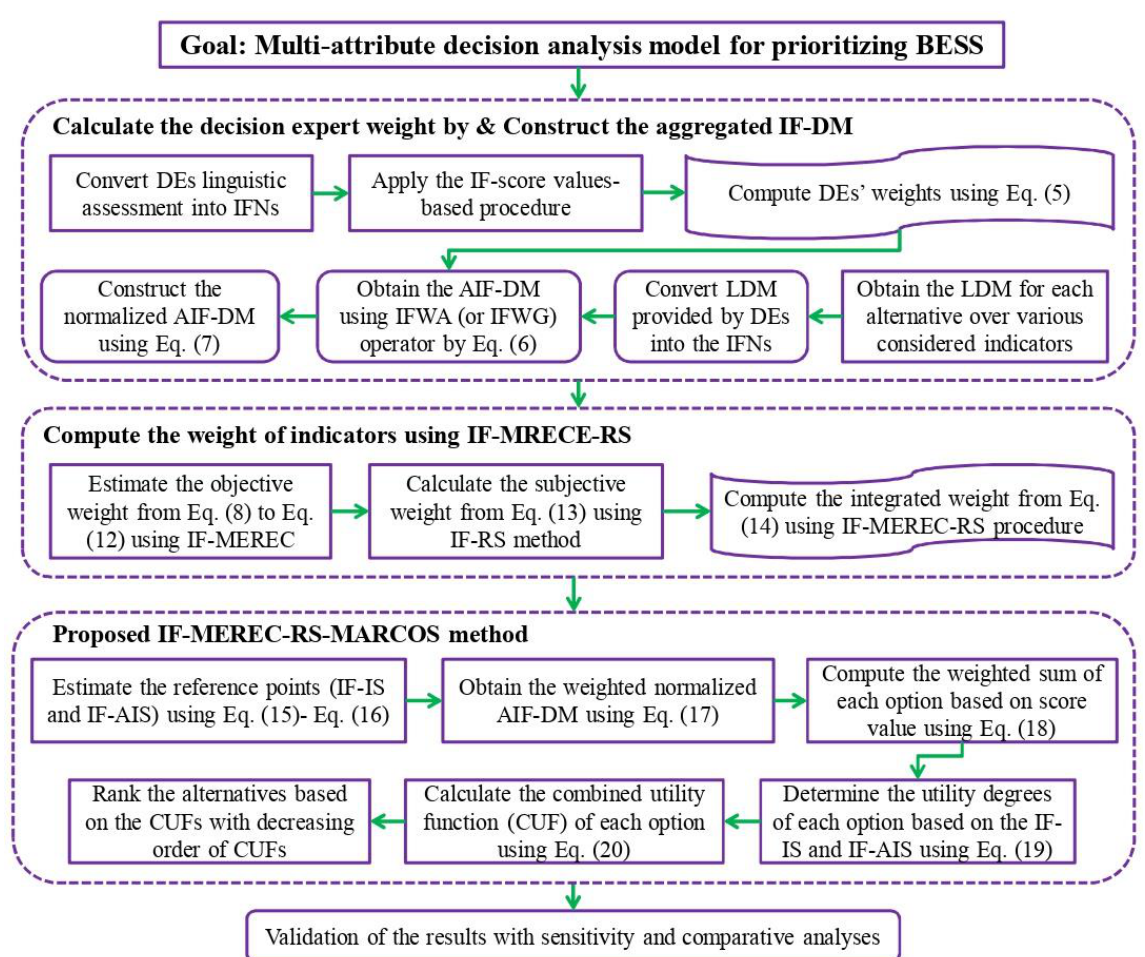
Figure 1. Flowchart of the proposed methodology.